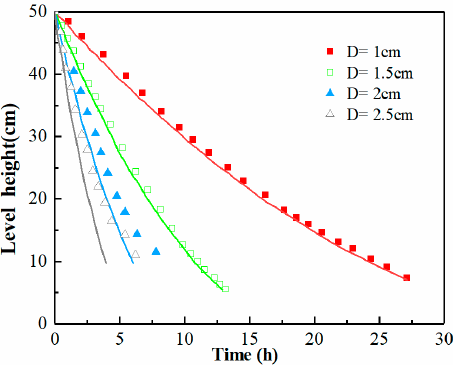
Figure 4. The height of the liquid level decreases with time in a quadratic curve. Dotted data represent measured values; solid lines represent theoretical values.